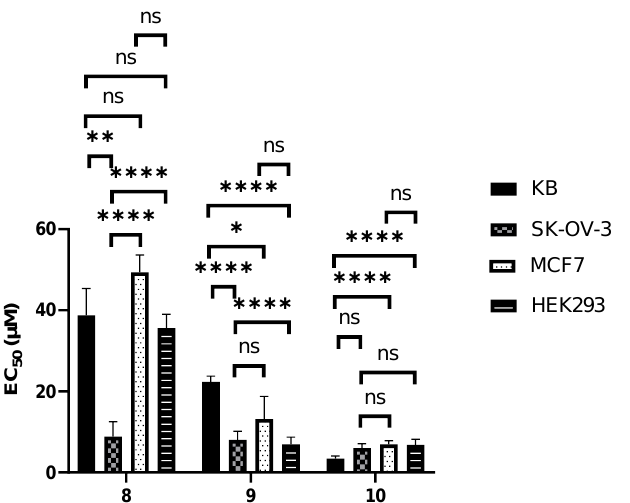
Figure 2. Cytotoxicity of cyanine dye and folate labelled compounds 8 – 10 in KB, SK-OV-3, MCF7 and HEK293 cells. Bars represent the standard error of the curve fitted using Origin. Statistical analysis was performed by applying the extra sum-of-squares F test, performed using GraphPad Prism version 9 for Windows, GraphPad Software, La Jolla California USA, www.graphpad.com. ns = not statistically significant, * = p < 0.05, ** = p < 0.01, **** = p < 0.0001.